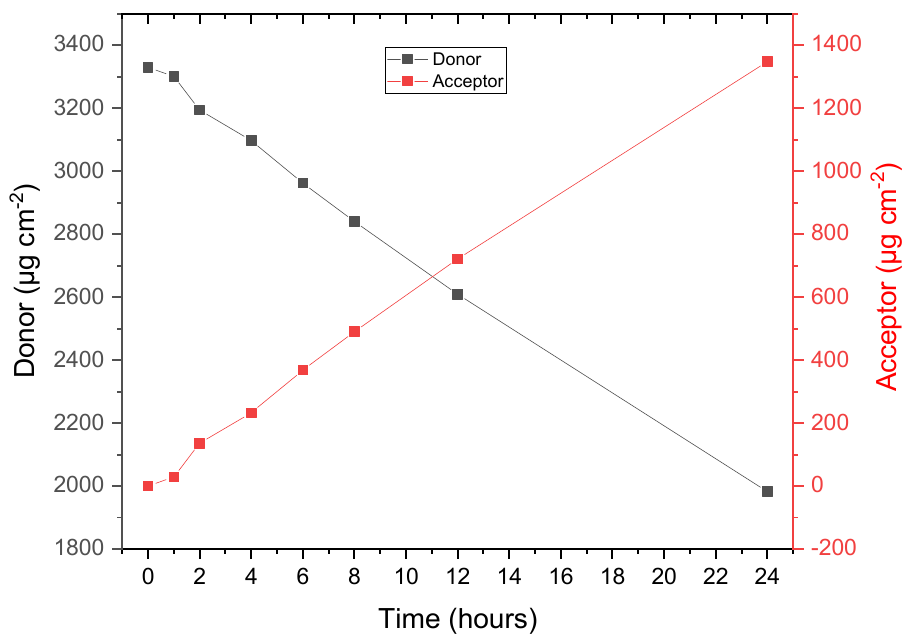
Figure 6. API release from formulation THQ:HPβCD.010 through a Nylon membrane.